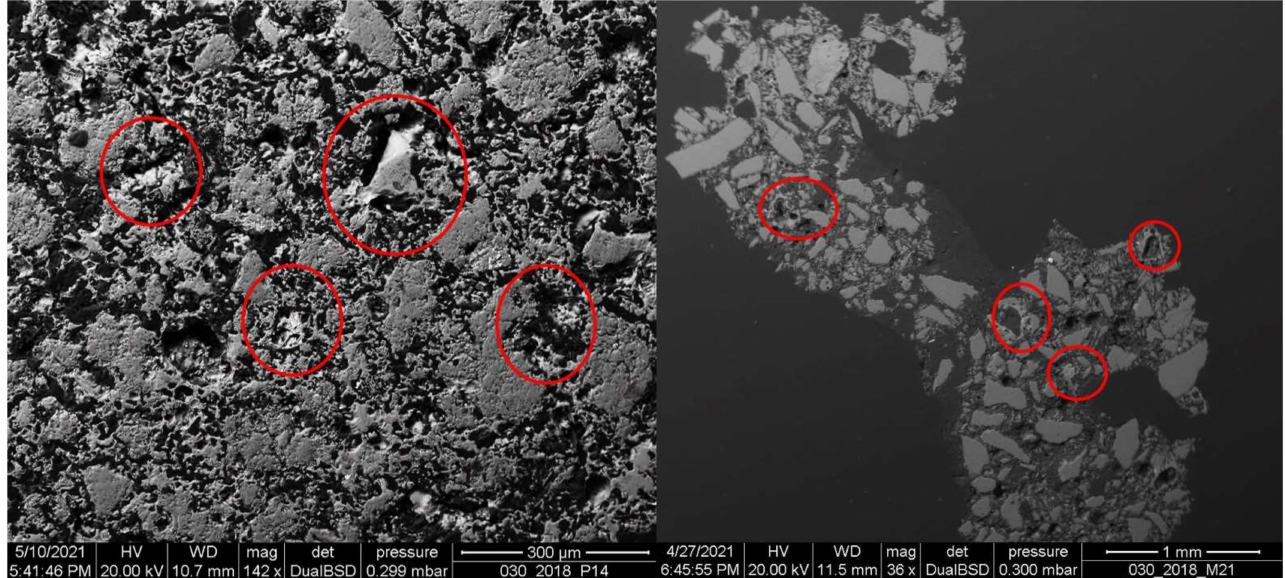
Figure 4. Back scatter electron images; glass particles in red circles. ( Left ) P14 (polychrome tile I. 4/67,24, group IID3c). ( Right ) M21 (monochrome tile ISL 7, group